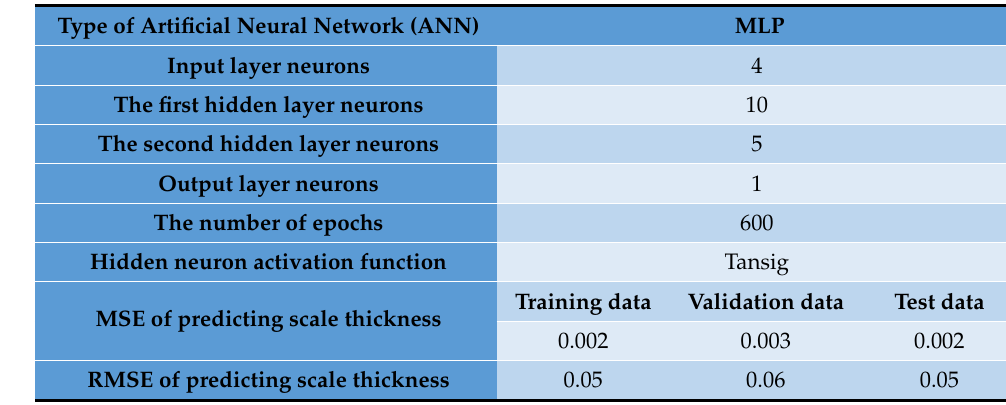
Figure 6. Fitting, regression, and error histogram diagram for ( a ) training, ( b ) validation, and ( c ) testing data. Table 1. Designed network charectristics.